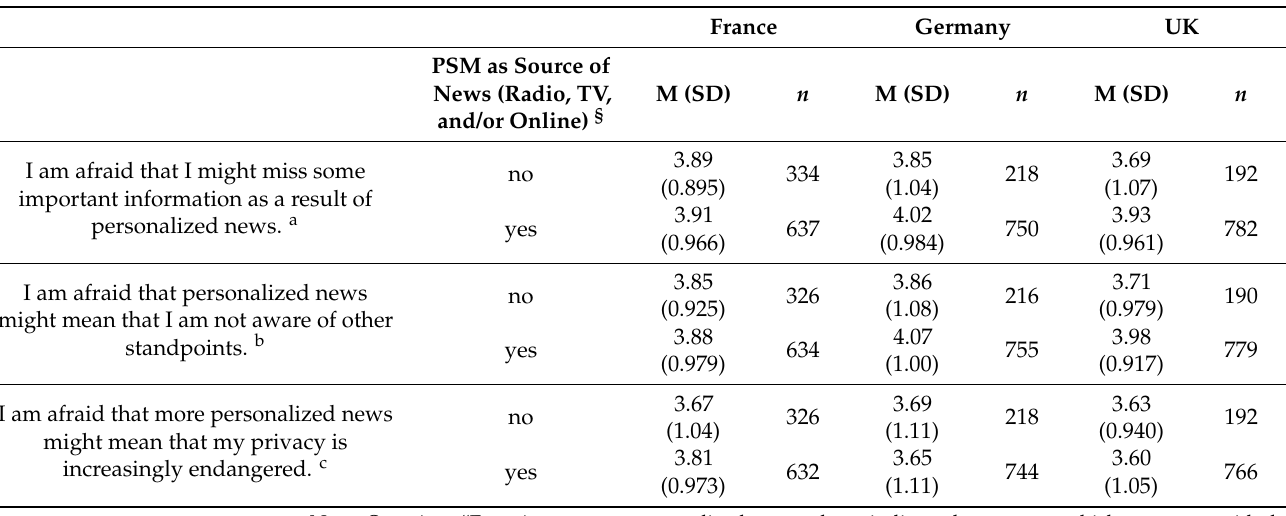
Table 1. Risks associated with the personalization of